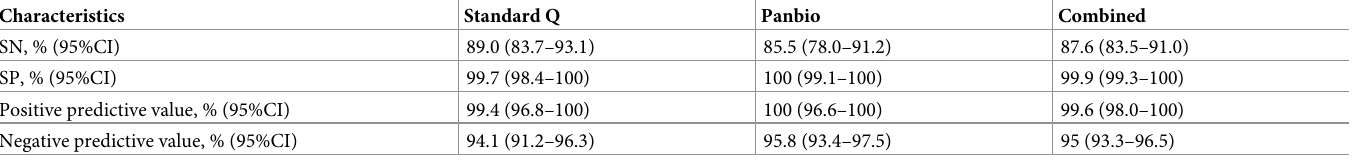
Table 2. Overall SN, SP, positive and negative predictive value of Standard Q and Panbio SARS-CoV-2 Ag-RDT. Characteristics